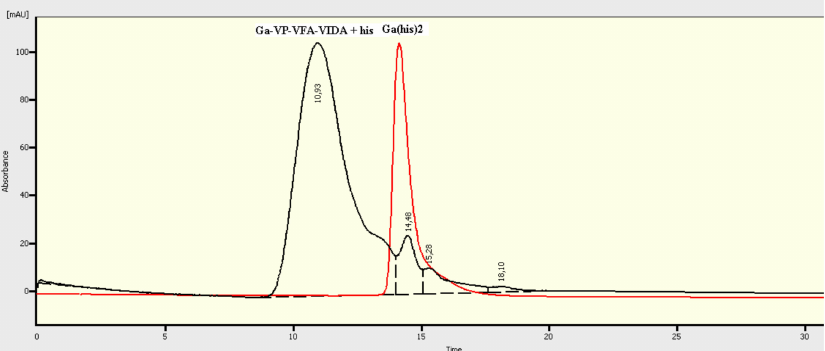
Figure 4. SEC profiles of conjugate between VP-VFA-VIDA-Ga and histidine, and the model complex Ga(His) 2 + . Column: ultrahydrogellinear 0.78 × 30 cm, 0.6 × 4 cm, eluent: 0.2 М NaCl; elution rate: 0.8 mL /